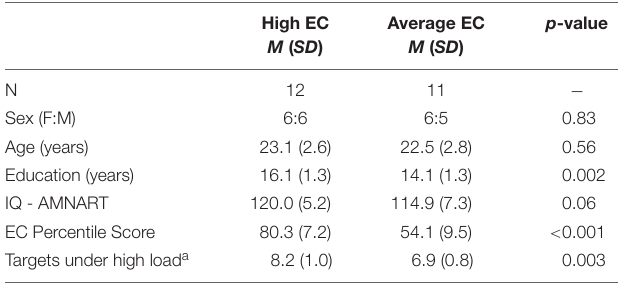
TABLE 2 | Demographic and neuropsychological characteristics of each Executive Capacity (EC) group.